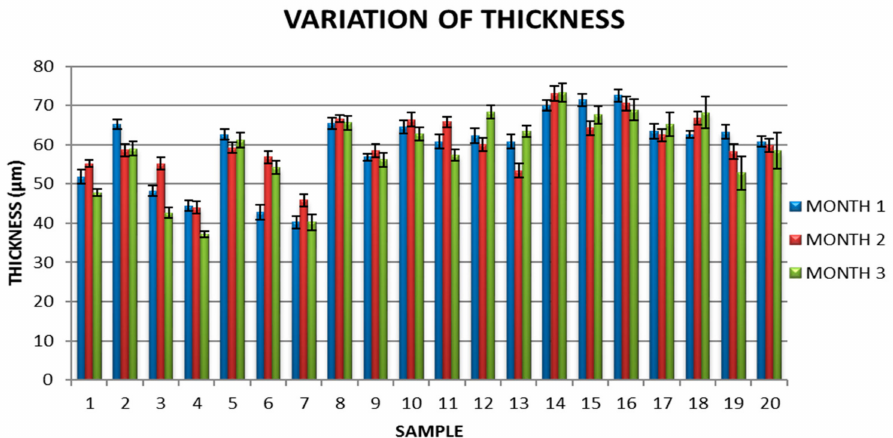
Figure 5. Values of mechanical properties in order to obtain a resistant and elastic film with minimal roughness.